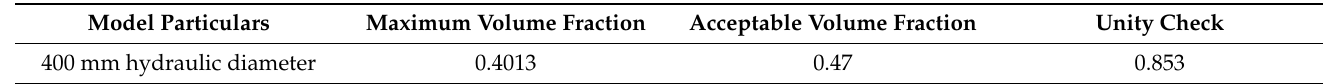
Table 5. The centralized values for wash water